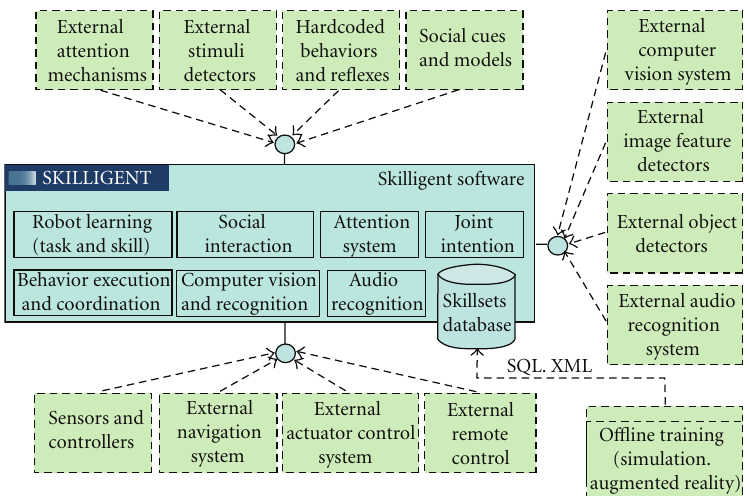
Figure 8: Various external software modules attached to the Skilligent Control System (reproduced from [61] with permission of